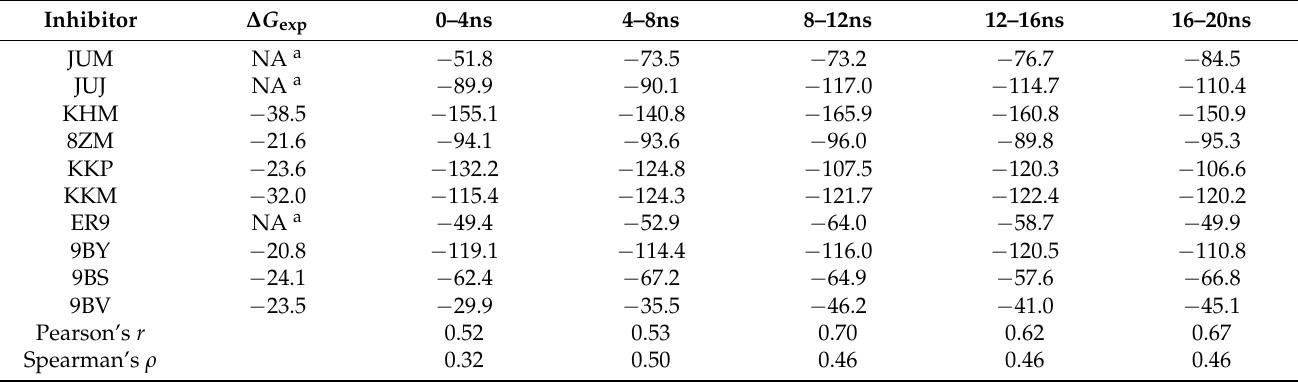
Table 3. Comparison of experimental binding energy ( ∆ G exp ) and the estimated binding free energy, ∆ G bind (kJ/mol), at different time scales obtained from MM/PBSA analysis, along with Spearman’s rank correlation coefficient ( ρ ) and Pearson correlation coefficient ( r ).